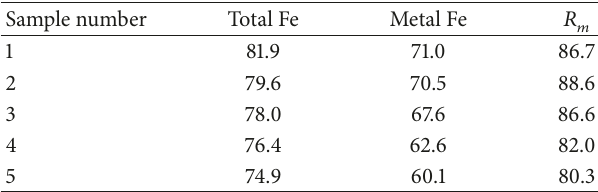
Table 4: Degree of metallization of carbon-bearing pellets after re- duction roasting